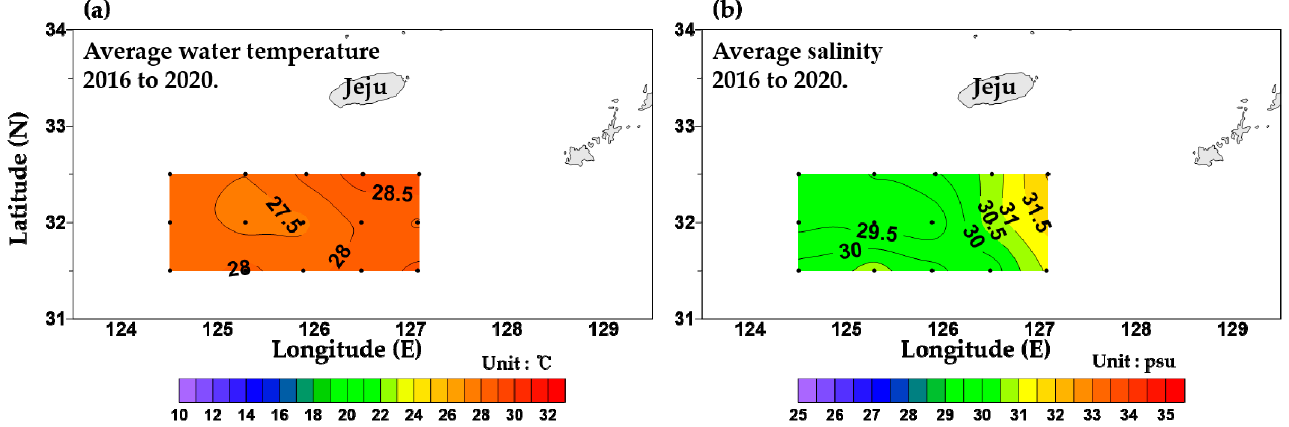
Figure 3. Spatial distribution of the average surface temperature ( a , °C) and average surface salinity ( b , psu) in the northern East China Sea from 2016 to 2020.